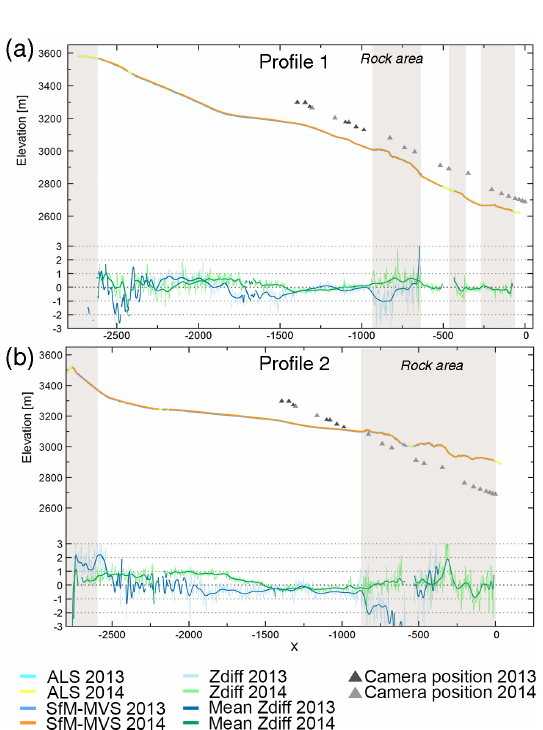
Figure 7. Cross sections through the La Mare Glacier DEMs show the glacier elevation change and the difference between 2013 and 2014 in SfM–MVS and ALS-based DEMs. The location of (a) pro- file 1 and (b) profile 2 is indicated in Fig. 6. The x axis zero has been fixed at the first camera position of the 2014 survey and the minimum and maximum values of the z -difference set to ± 3m and both profiles and the camera positions were projected onto the xz plain. The shaded area represent bare-ground stable areas.